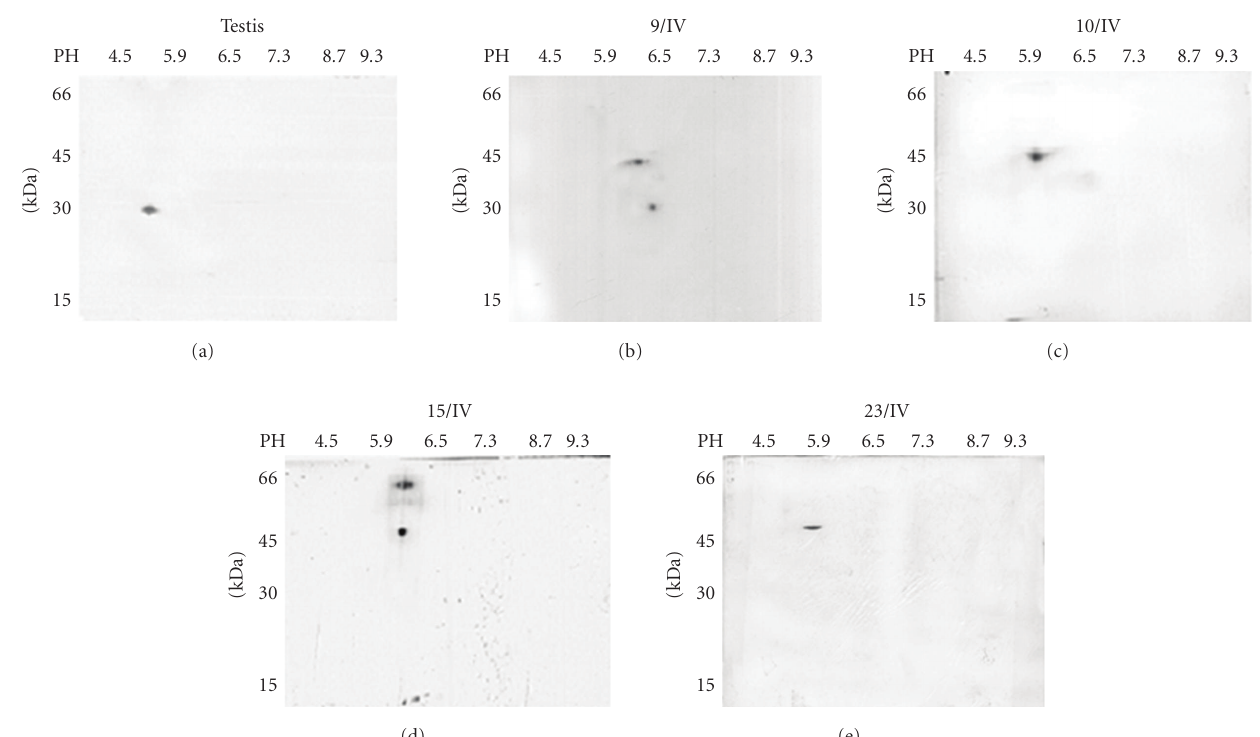
Figure 4: Isoelectric point determination of Dpl protein in nonneoplastic human testis and in glioblastoma multiforme (GBM) samples. 2D-PAGE was performed using 60 μ g of purified protein samples on a linear immobilized pH gradient (i.e., pH 3–10), followed by a 12% SDS-PAGE. Dpl was then detected by immunoblotting as reported